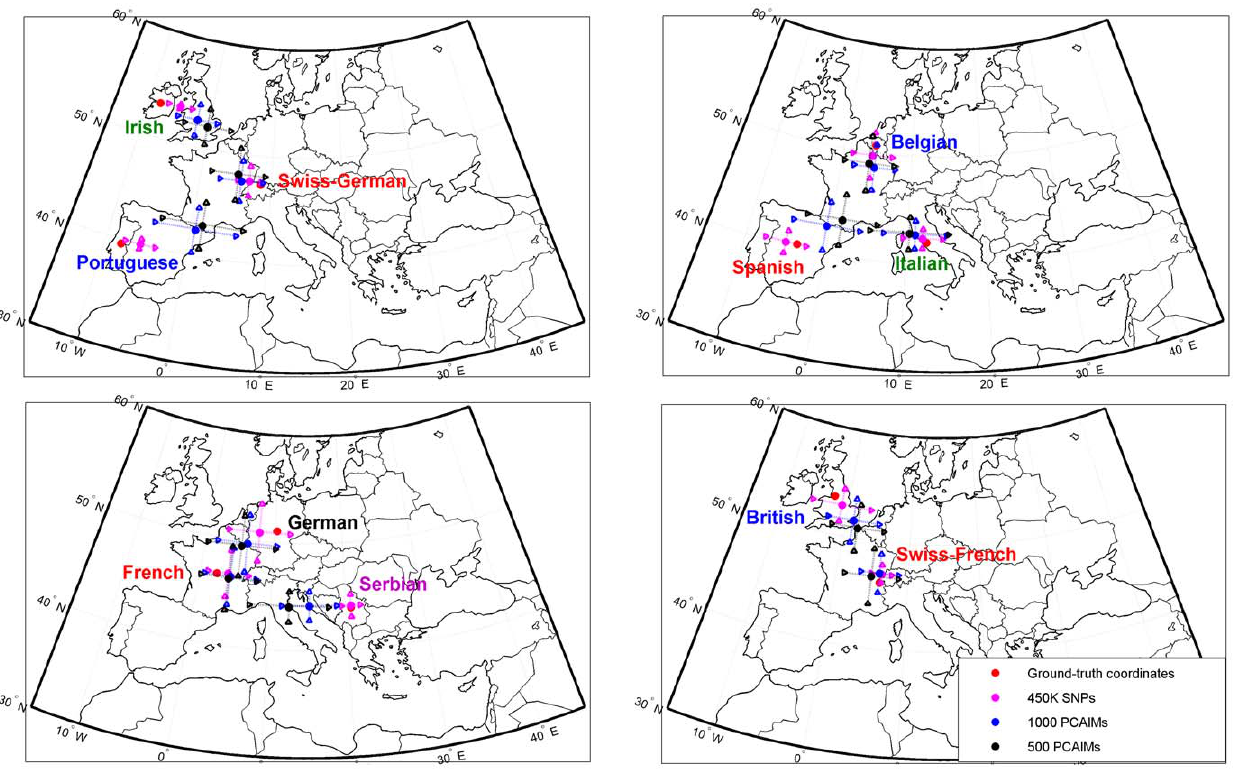
Figure 1. Complete leave-one-out cross-validation experiment. Predicted ancestry location (and standard deviation) of studied individuals using PCAIM panels of different sizes. Reference geographic locations associated with each population were assigned using the central point of the geographic area of the country as in Novembre et al. [15].